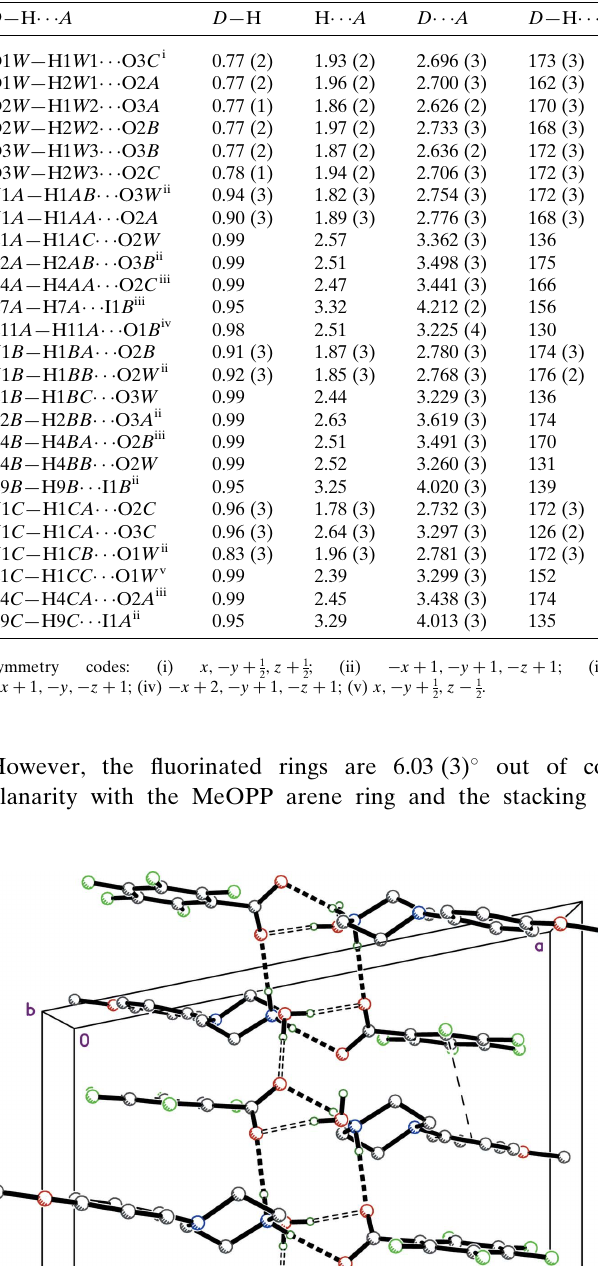
Table 4 Hydrogen-bond geometry (A˚ , (cid:5) ) for IV .